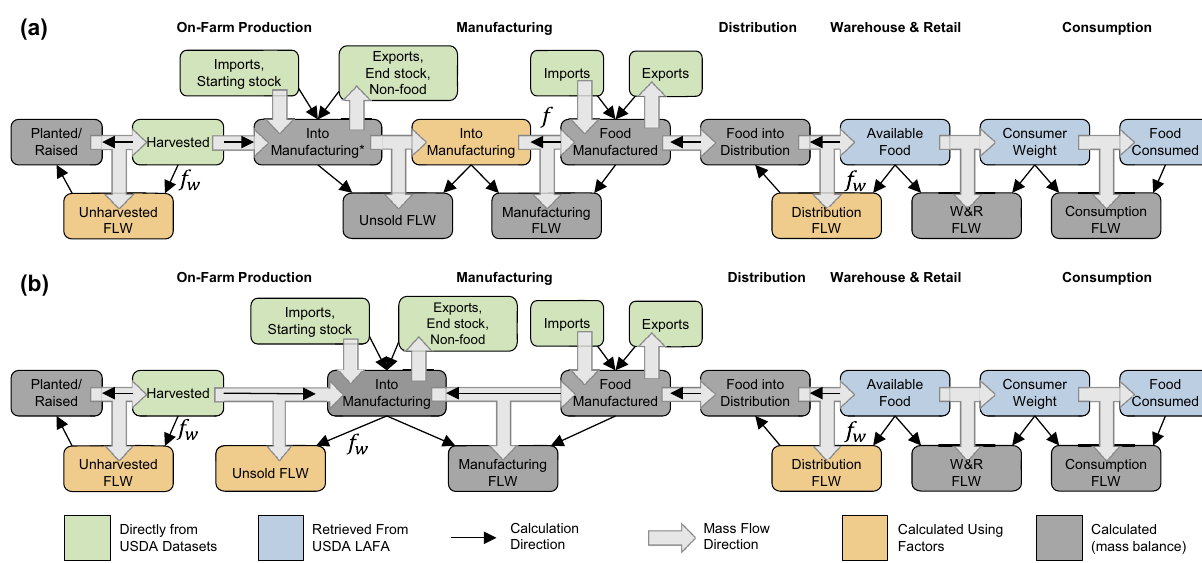
Fig. 8 Accounting approach and main source of data for estimating mass fl ow and food loss and waste (FLW) generation. The green and blue boxes represent the data directly taken from datasets (the US Department of Agriculture [USDA]; USDA ’ s Loss Adjusted Food Availability Data [USDA LAFA]), the orange boxes indicate the mass fl ow calculation is estimated based on coef fi cients (shown by f and f w , representing factors for calculating a stage output and input, respectively), and the gray boxes correspond to the mass obtained by mass balance. The thicker gray arrows represent the direct of mass fl ow, whereas the smaller black arrows represent the calculation fl ow. Grains, fruits, vegetables, seafood, and nuts products use the approach described in panel a . Oil, sugar, meat and poultry, dairy, and egg products use the approach described in panel b